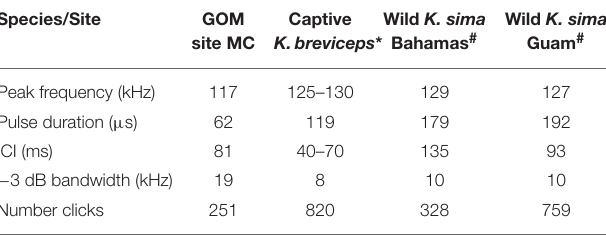
TABLE 1 | Comparison of median peak frequency, pulse duration, Inter-click-interval (ICI) and − 3 dB bandwidth for Kogia spp. from site MC 320kHz sample rate recording and the same parameters for other reported encounters with Kogia including a captive K. breviceps and wild K. sima in the Bahamas and